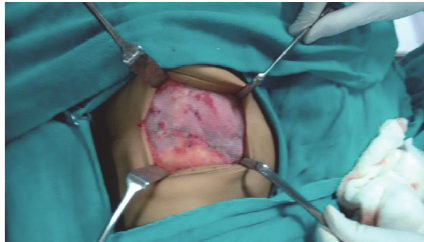
Figure 5: Open surgical repair with meshplasty.